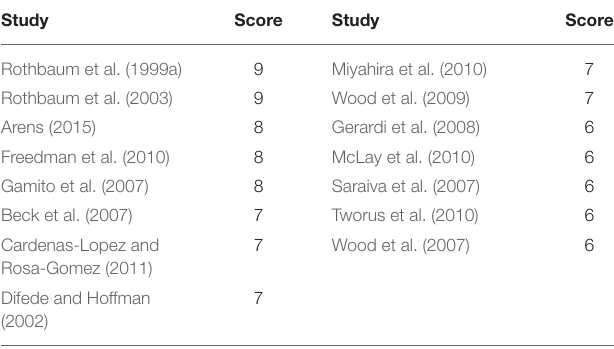
TABLE 2 | Quality assessment